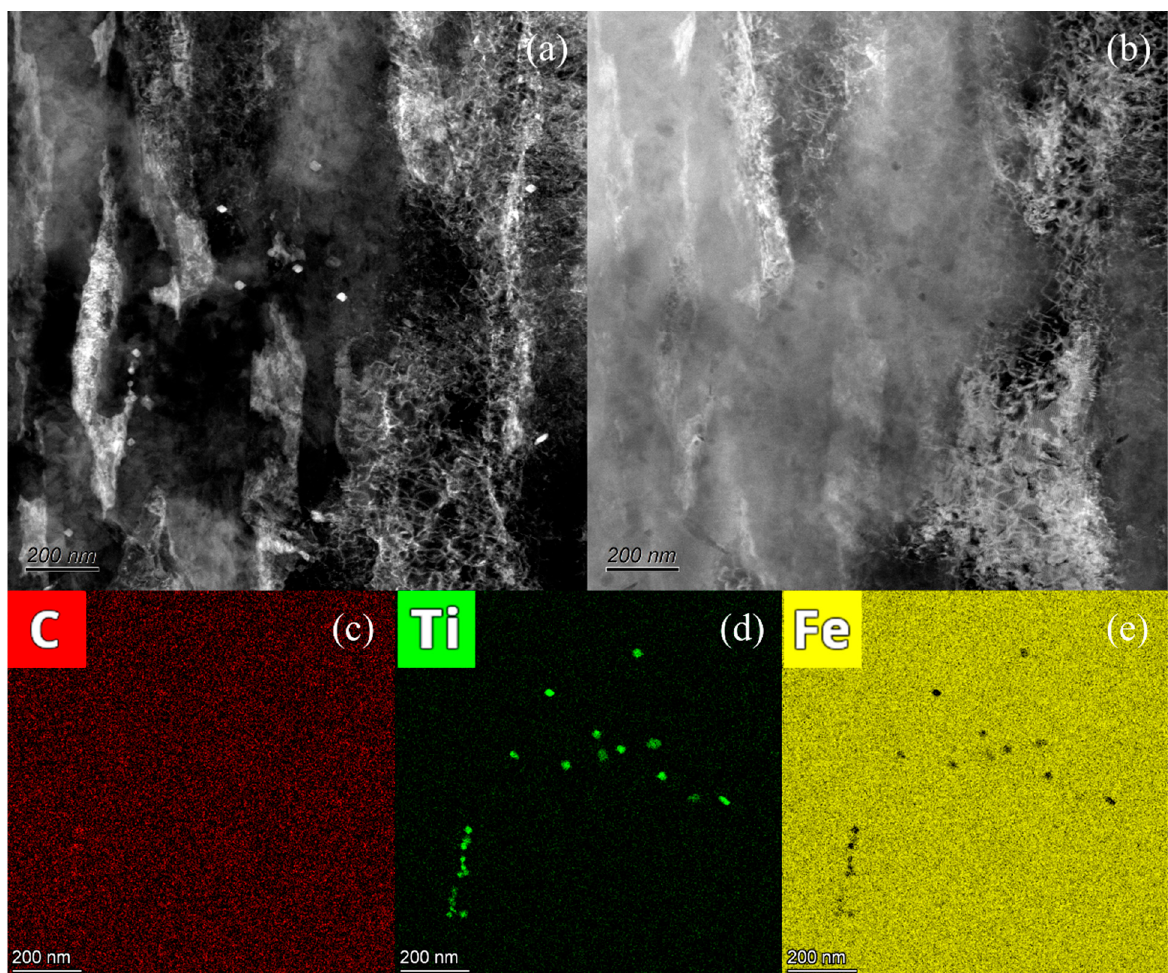
Figure 4. TEM image of Ti microalloyed steel deformed at 900 °C and held for 500s showing ( a ) dark field image; ( b ) HAADF image; and ( c – e ) corresponding EDS mapping.